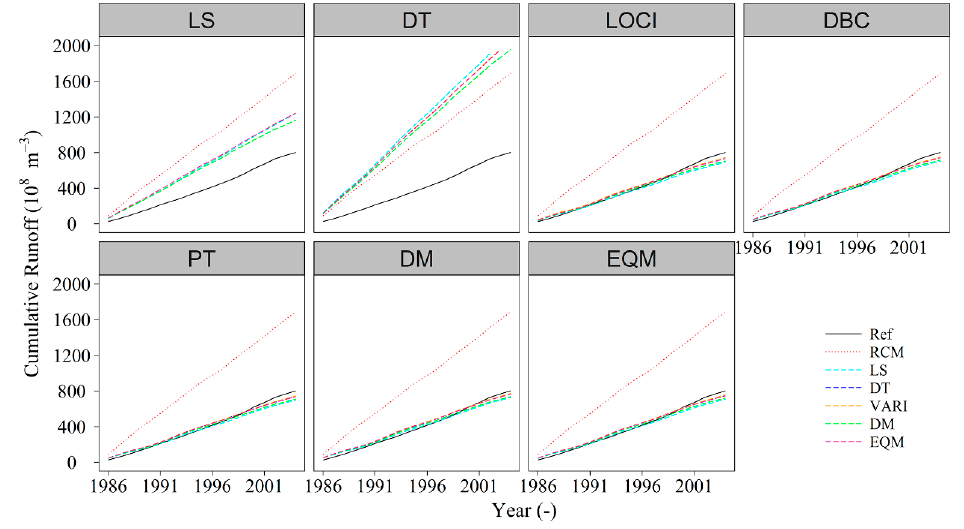
Figure 12. Cumulative runoff from 1986 to 2004 grouped by precipitation bias-corrected methods.